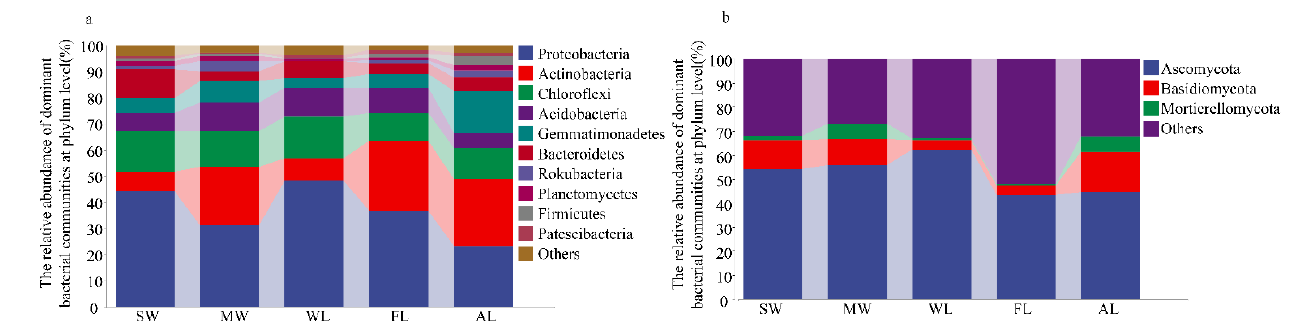
Figure 3. Microbial community composition at the phylum level. ( a ) Bacterial community abundance; ( b ) fungal community abundance. Different colors indicate different microorganisms at the phylum level. SW, swamp wetland; MW, meadow wetland; WL, woodland; FL, farmland; AL, alkaline land.